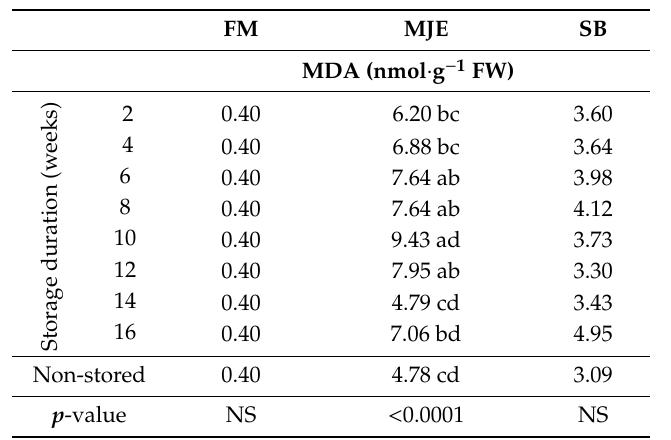
Table 6. Malondialdehyde (MDA) content in petals of Paeonia lactiflora cultivars Festiva Maxima (FM), Monsieur Jules Elie (MJE), and Sarah Bernhardt (SB) in response to storage duration independent of storage temperature and pre-storage